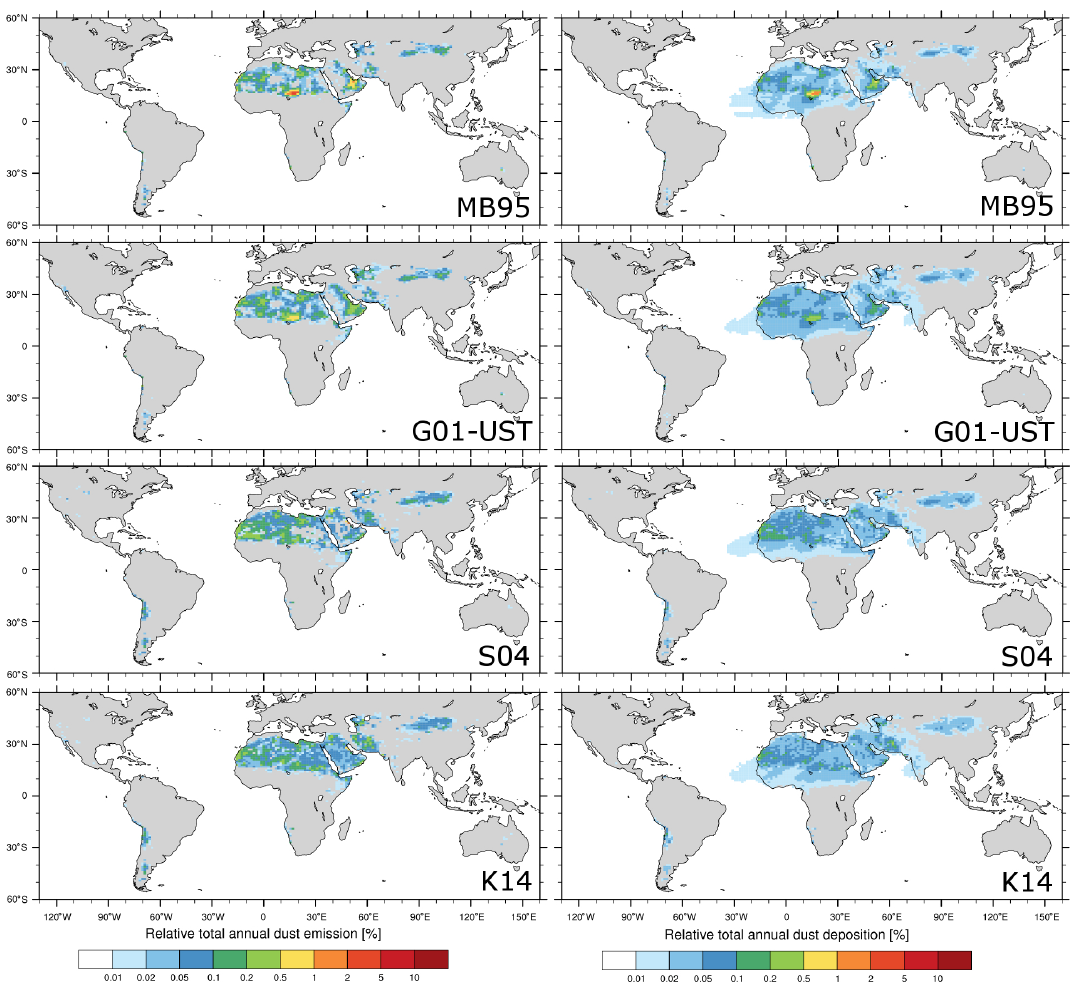
Figure A1. Percent contribution of dust emission (left column) and deposition (right column) to their respective global and annual totals for the four experiments described in Sect.